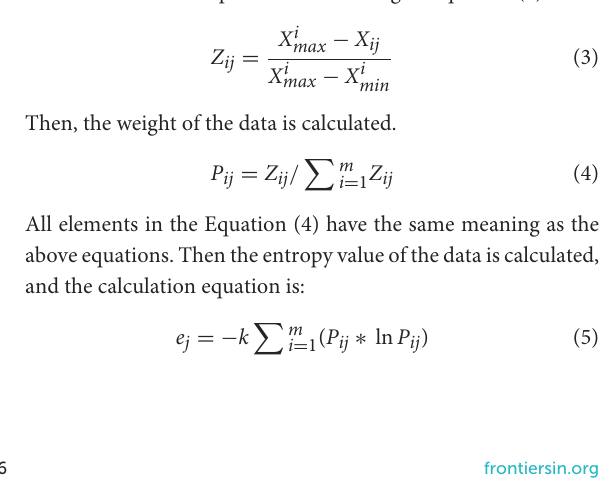
methods used are the entropy weight method and questionnaire survey method. The entropy weight method research needs represents the minimum value of the original data, and X i max represents the maximum value of the original data.